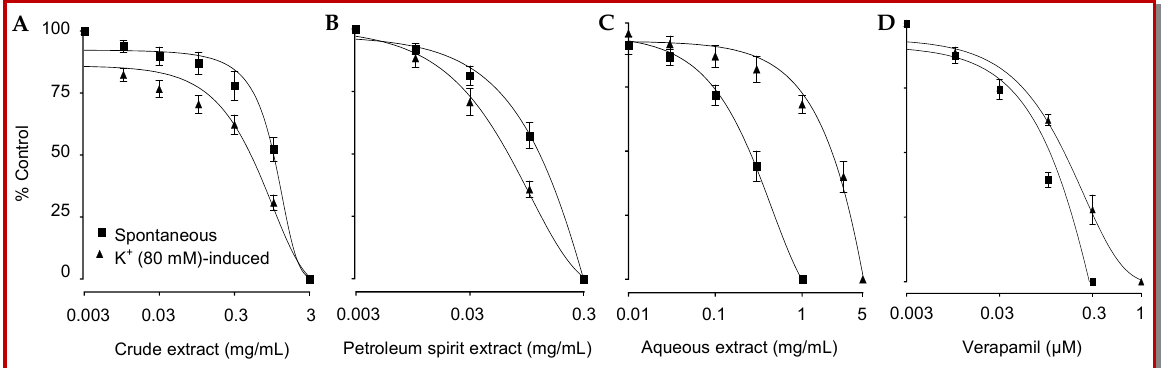
Figure 2: Concentration dependent effect of crude extract (A), petroleum ether extract (B), aqueous extract (C) and verapamil (D) on spontaneous and K + (80 mM)-induced contractions on isolated rabbit jejunum preparation. Values are expressed as the mean ± SEM, n = 5